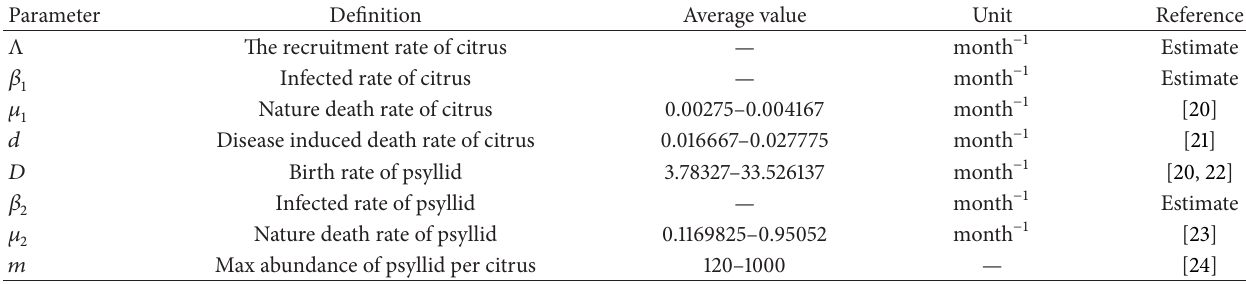
Table 1: Parameter definitions and values used for numerical simulations of the Huanglongbing model.